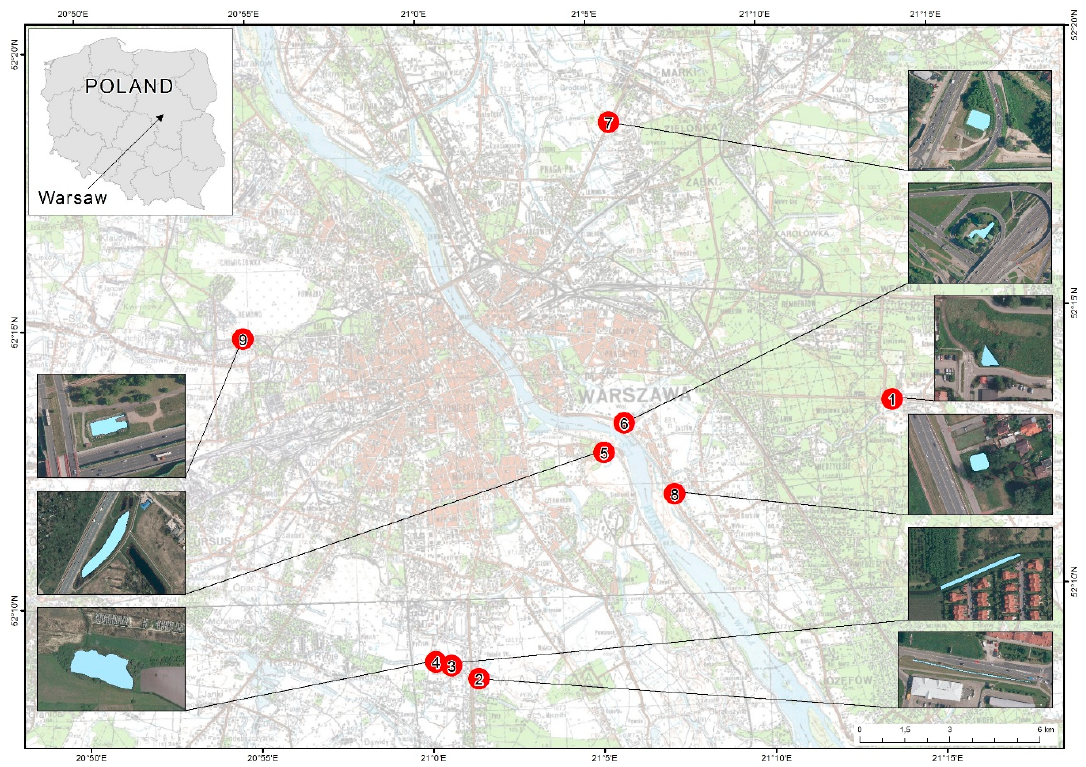
Figure 1. Aerial view of the study area and location of the sampling points. Table 1. Characteristics of selected points of the road drainage system within the Warsaw agglomeration. Sampling